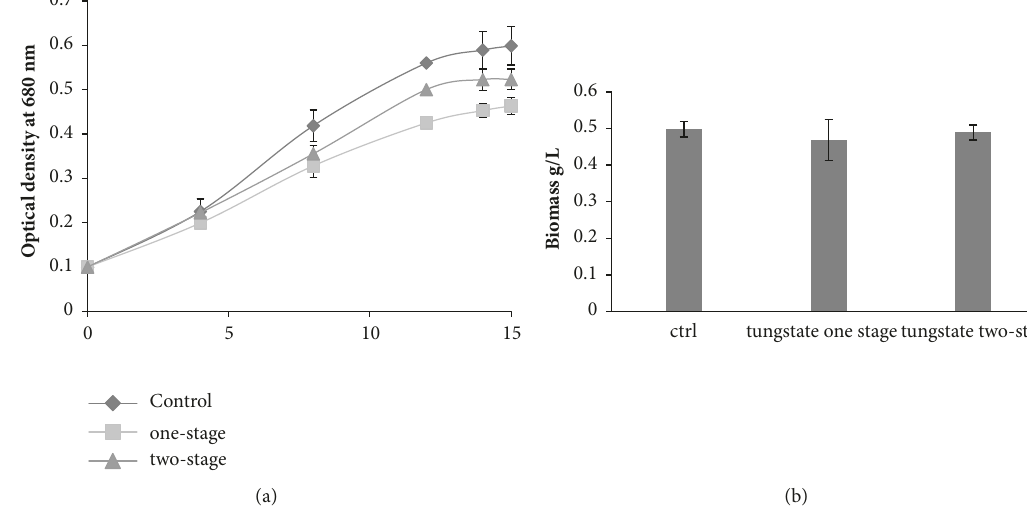
Figure 1: Effect of tungstate on growth of D. tertiolecta . (a) Monitoring of OD 680 nm during 14 days. (b) Biomass accumulated at 15th days of culture (g/L). All cultures were cultivated in Guillard F/2 medium. Sodium tungstate was added to the cultures at the beginning of culture “one-stage treatment,” or at 7h day “Two-stage treatment.”